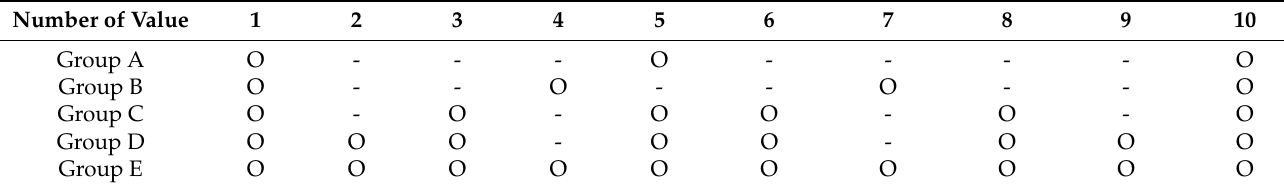
Table 2. Numbers of the values used in each group.